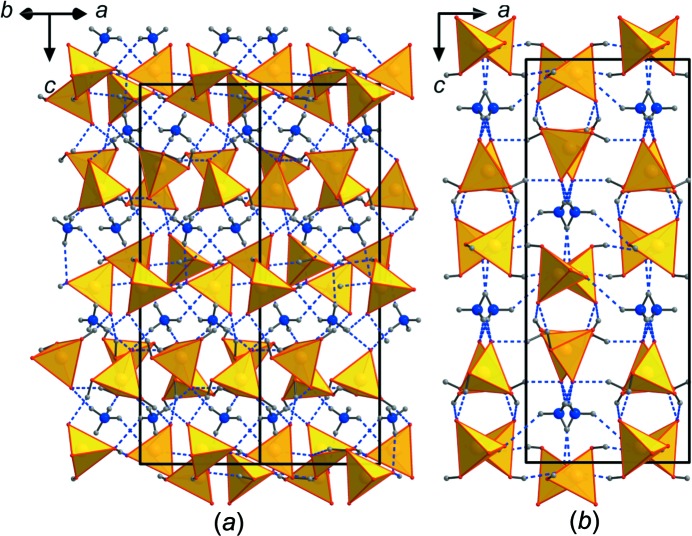
Structural drawings of (NH4)(H2AsO4)(H3AsO4), viewed along (a) [110] and (b) b. The unit cell is outlined. AsO4 tetra­hedra (yellow) are connected via multiple hydrogen bonds (blue dashed lines) into a 3D network. AsO4 tetra­hedra and NH4
+ cations are arranged in layers perpendicular to c. Additional hydrogen bonds of medium strength are provided by the NH4
+ cations.